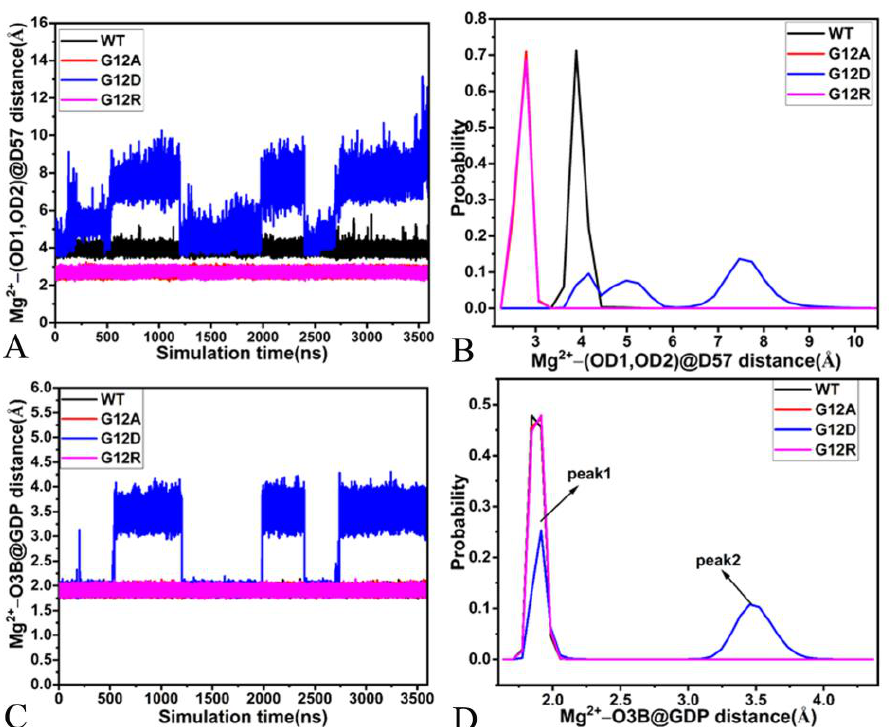
O of D33 and its probability distributions, individually.